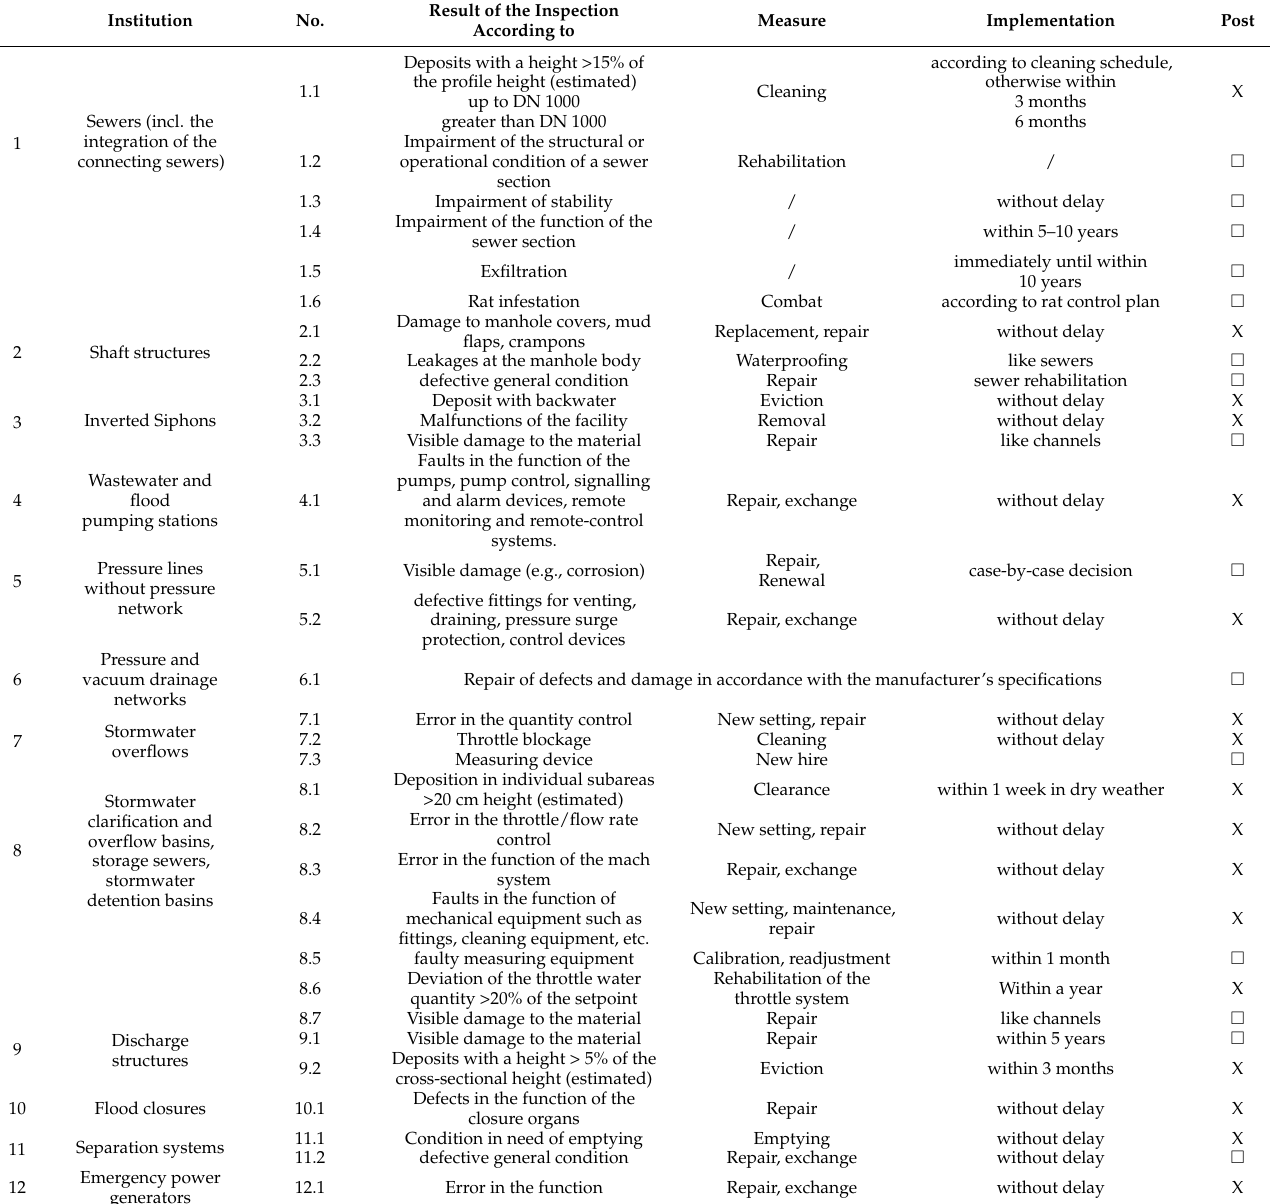
Table 2. Operational measures of the wastewater utility with contribution to flood prevention: X.